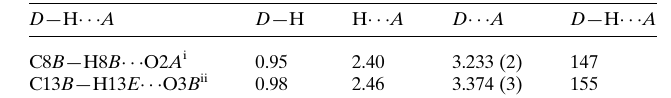
Table 1 Hydrogen-bond geometry (A˚ , (cid:2) ).